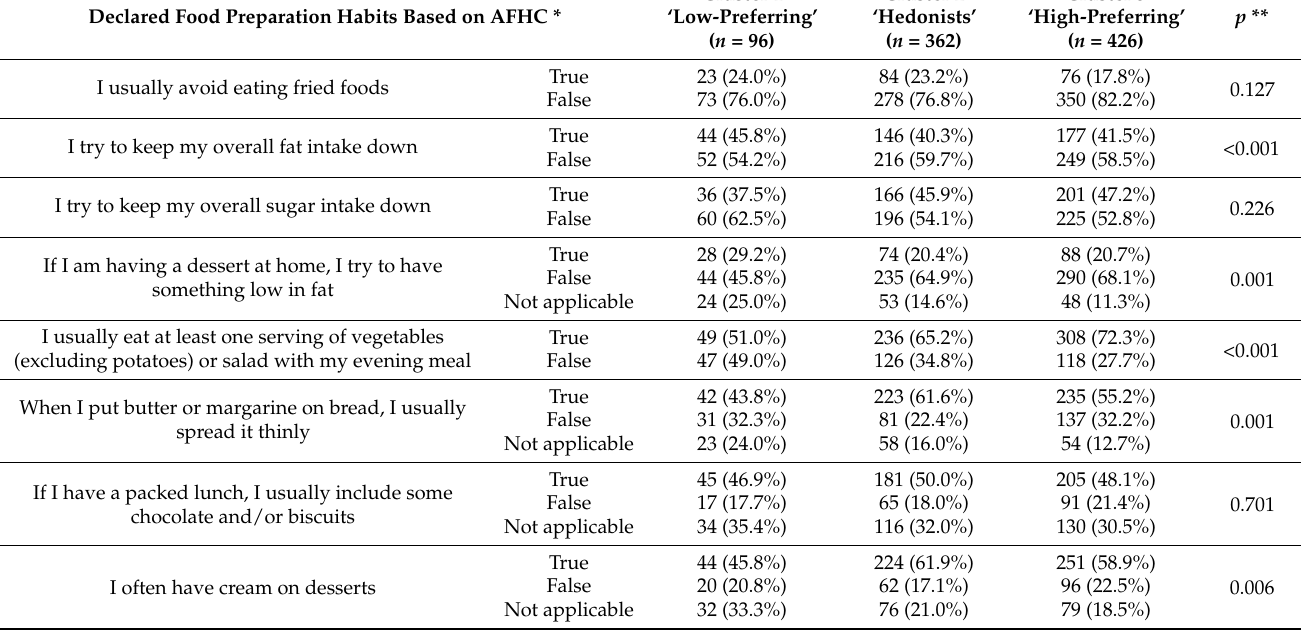
Table 10. The declared food preparation habits assessed based on the Adolescents’ Food Habits Checklist (AFHC) in the clusters stratified based on the preferences assessed while using the Food Preference Questionnaire (FPQ) within the male population of the second phase of the Polish Adolescents’ COVID-19 Experience (PLACE-19) Study ( n = 884). Declared Food Preparation Habits Based on AFHC